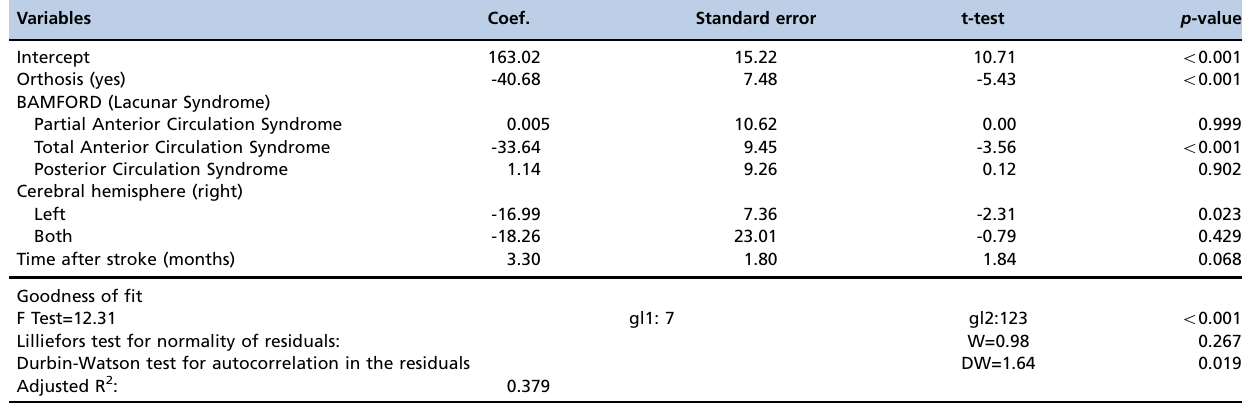
Table 4 - Multiple linear regression model for quality of life of patients with stroke based on the Stroke Specific Quality of Life Scale. Variables